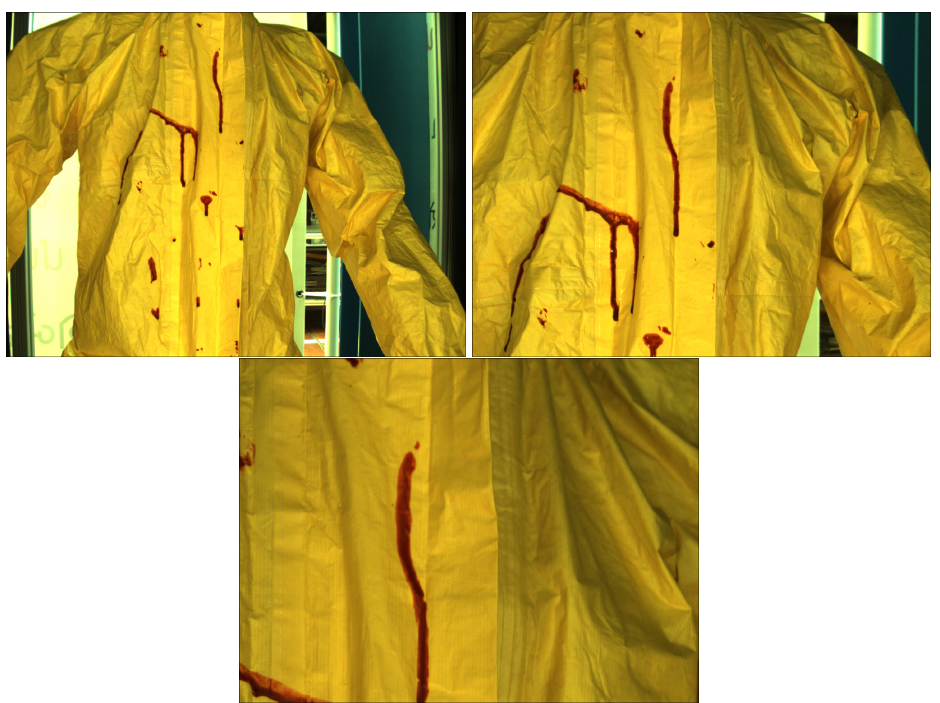
Figure 7. Physical emulated dataset respectively with different zoom levels: the ( upper left ) image represents 4.88 mm of focal length (0% zoom), the ( upper right ) image corresponds to 31.92 mm focal length (60% zoom), and the ( bottom ) image with focal length of 57.6 mm (100% zoom). Such high intensity LED illumination technology provides information in a wide spectrum, ranging from UV to IR, in particular: (a) white light is used for blood stains, bruises and bites; (b) UV light for body fluids and drug residues; (c) violet light for splashing blood and hair; (d) orange and red light for general contrast search; and (e) IR light for blood splashes, fiber, etc. [59]. In view of the detection of exclusively blood stains, temporarily the white light was the only one